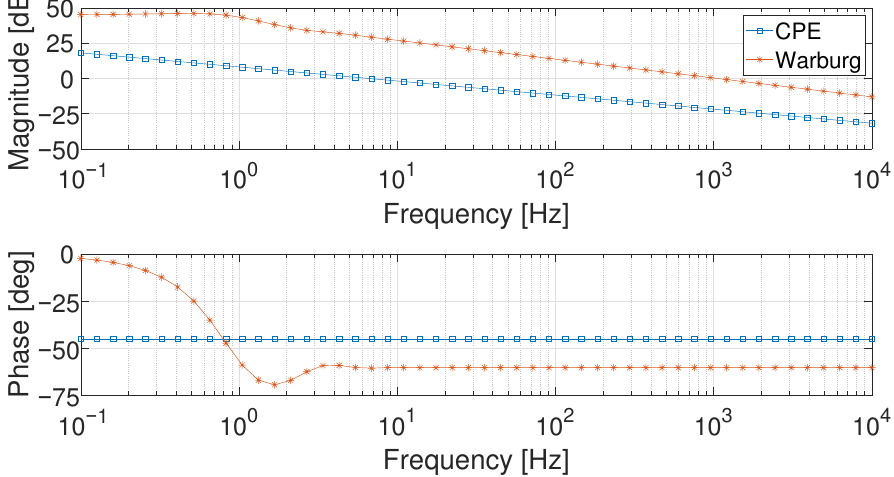
Figure 2. Constant-Phase Element (CPE) and Warburg impedance, described by (5) and